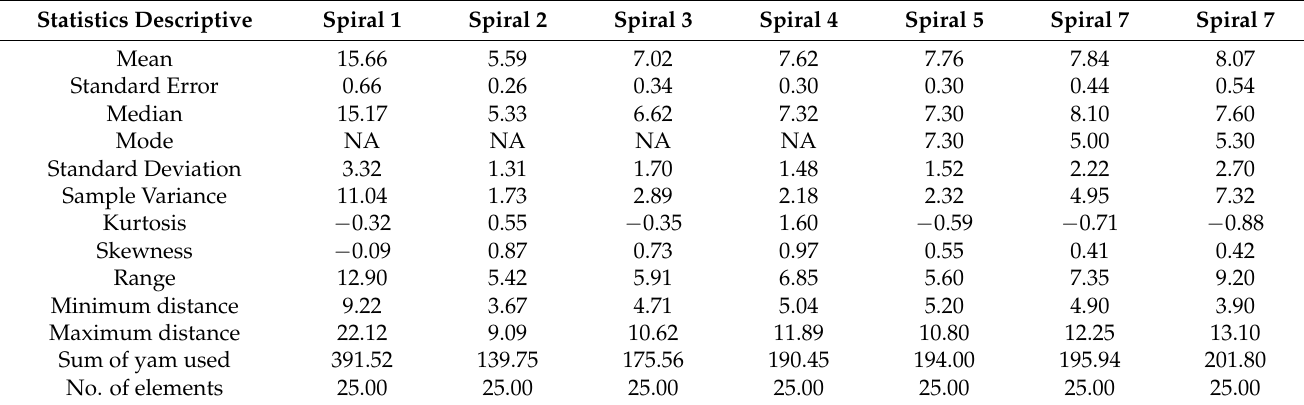
Figure 9. Geometrical measure of orb image of spider web and its statistical data report. Table 3. Geometrical extracted data of node to node size for sample SP5.